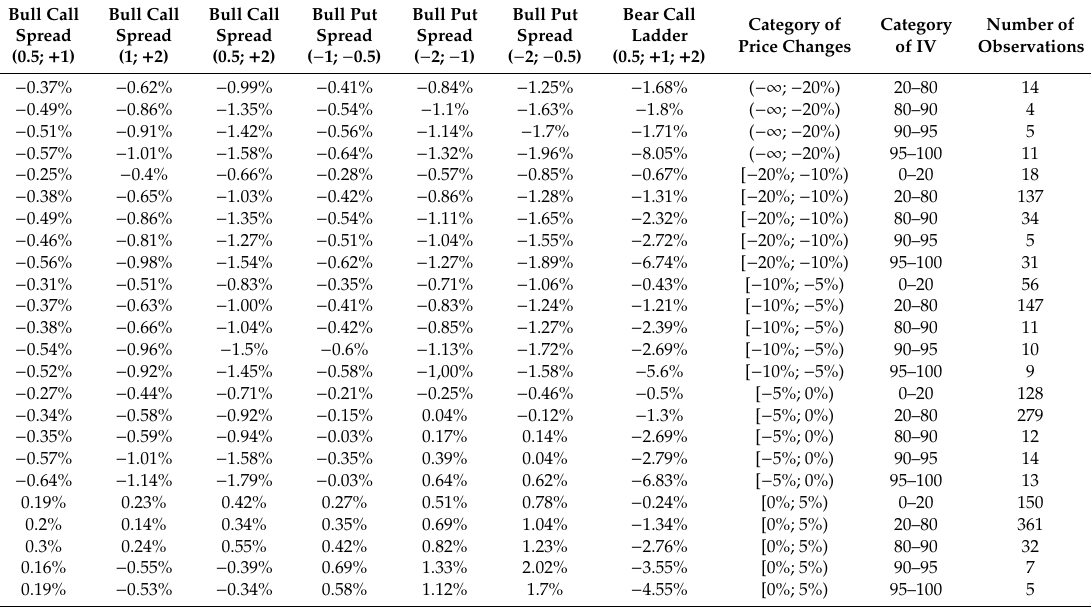
Table A4. Bull put spread, bull call spread, and bear call ladder